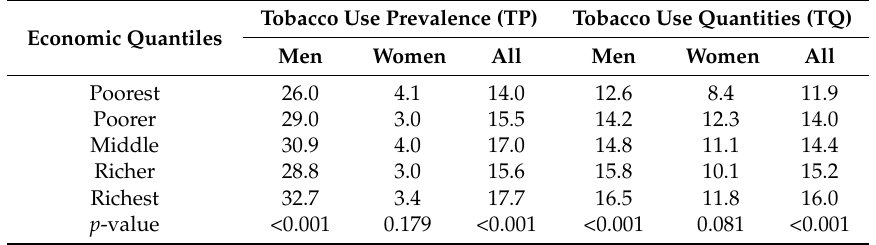
Table 2. Tobacco use prevalence and tobacco use quantities for the older adults in different economic quantiles in China.